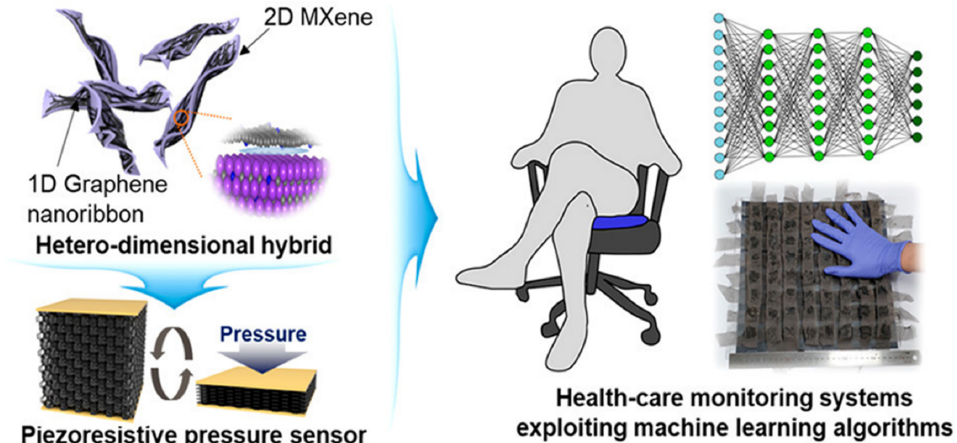
Figure 6. Interfacing interconnection of 1D graphene nanoribbons with 2D Mxene for developing pressure sensors trained using a machine learning algorithm. (Reproduced with permission from the American Chemical Society [66]).